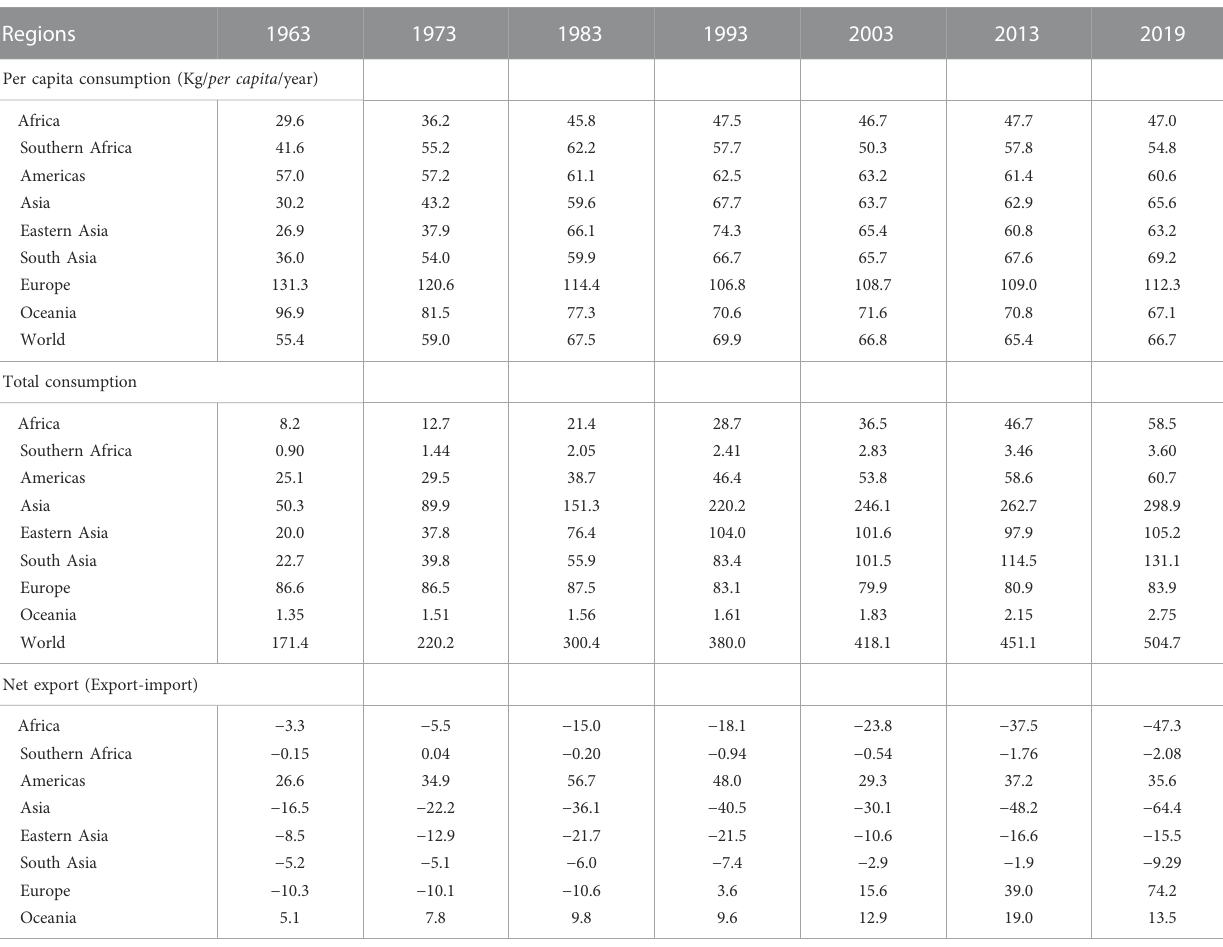
TABLE 2 Temporal changes in wheat consumption, and net exports (million metric tons) by major regions in the world. Regions